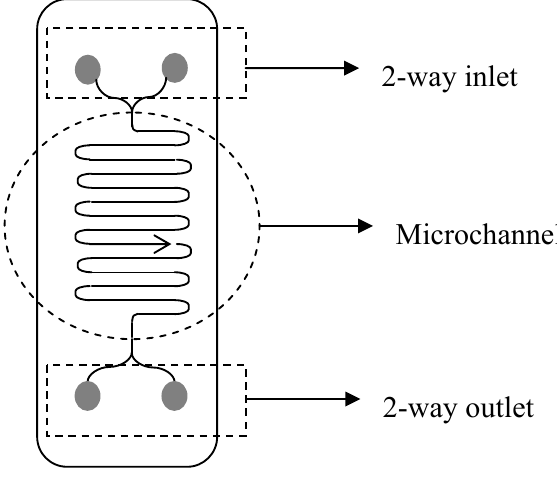
Figure 1. Scheme of a typical microfuidic device, with a microchannel and 2-ways inlet and outlet. Microreactors are commercially available from Chemtrix, CPC–Cellular Process Chemistry Systems GmbH Ehrfeld Mikrotechnik, Micronit/Future Chemistry, Microinnova, Mikroglas, Syrris, among